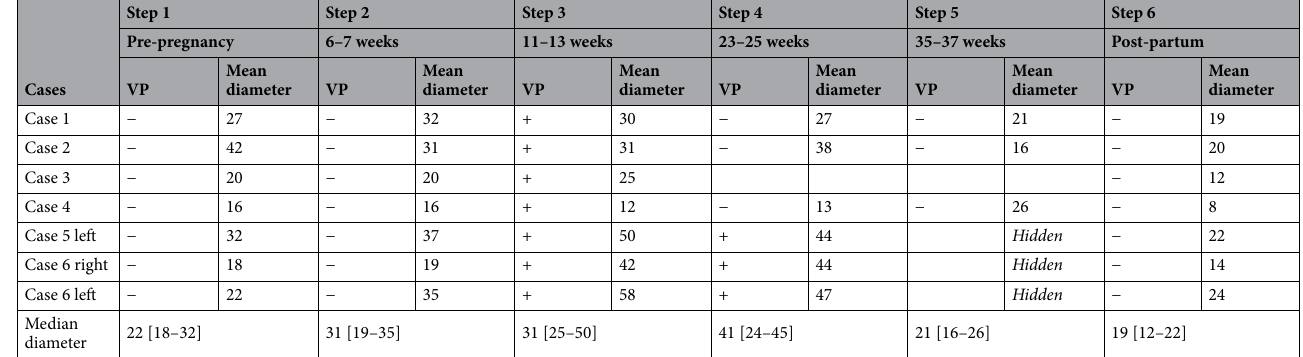
Table 3. Decidualization of endometriomas during pregnancy. Only the seven cases who showed typical signs of decidualization in at least on of the assessments are included in the table. VP vascularized papillary projection. Present (+) or absent (−). Hidden means that the lesion could not be seen because of the pregnancy. Empty boxes mean that the woman did the not perform the assessment. Mean diameter of the endometrioma is reported (in mm). Median diameter is presented with the interquartile